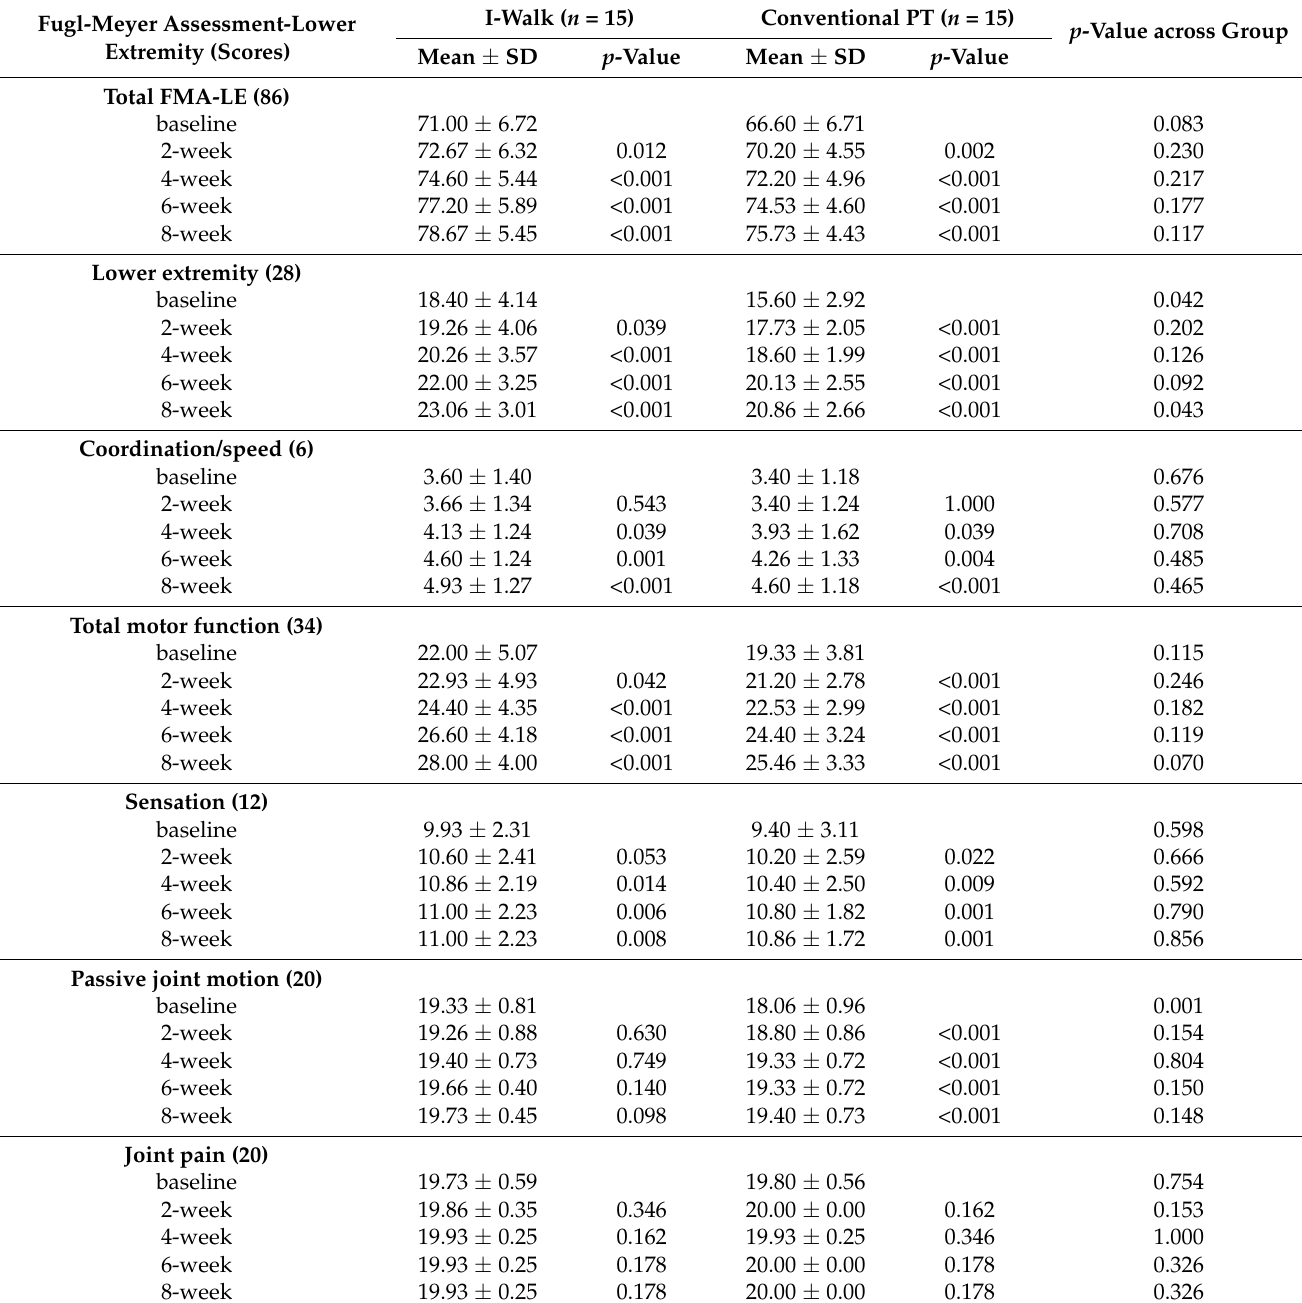
Table 2. Changes of lower extremity impairment scores during 8-week gait training compared within (compared with baseline) and across groups (Conventional PT and I-Walk) in chronic